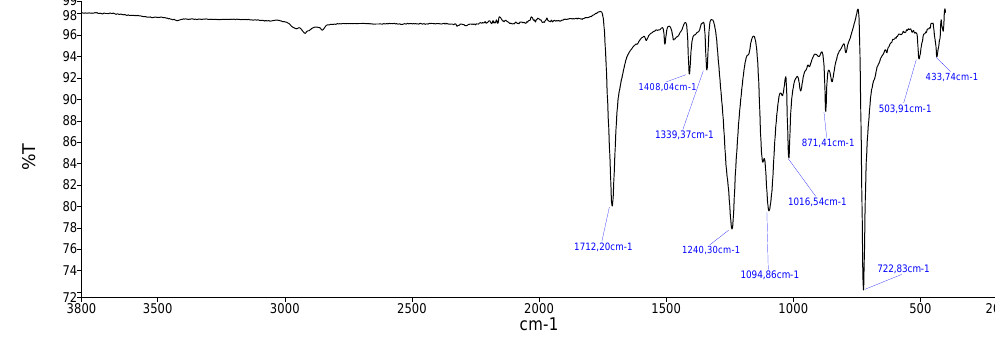
Figure 4. IR spectra of bicomponent filaments.